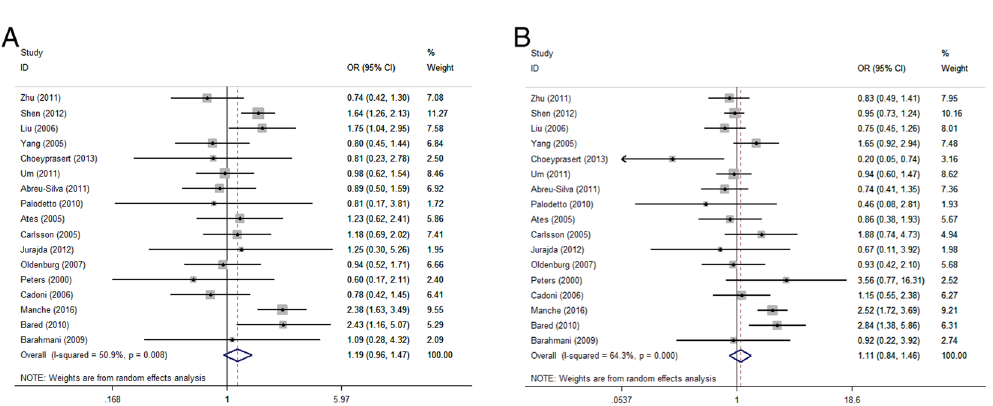
Figure 2. Forest plot presenting the association between GST M1 ( A ) and T1 ( B ) polymorphisms and the susceptibility to acquired